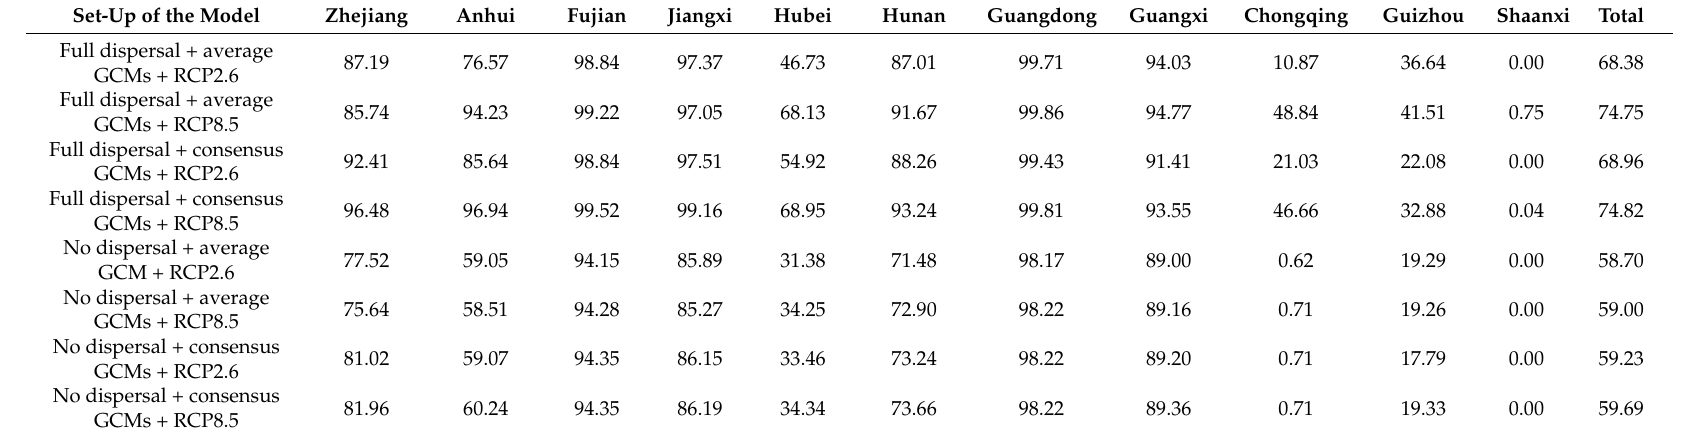
Table 4. Overlaps between the projected suitable habitats and the areas of provinces selected for growing Sapindus mukorossi in China. Set-Up of the Model Zhejiang Anhui Fujian Jiangxi Hubei Hunan Guangdong Guangxi Chongqing Guizhou Shaanxi Total Full dispersal + average GCMs + RCP2.6 Full dispersal + average GCMs +